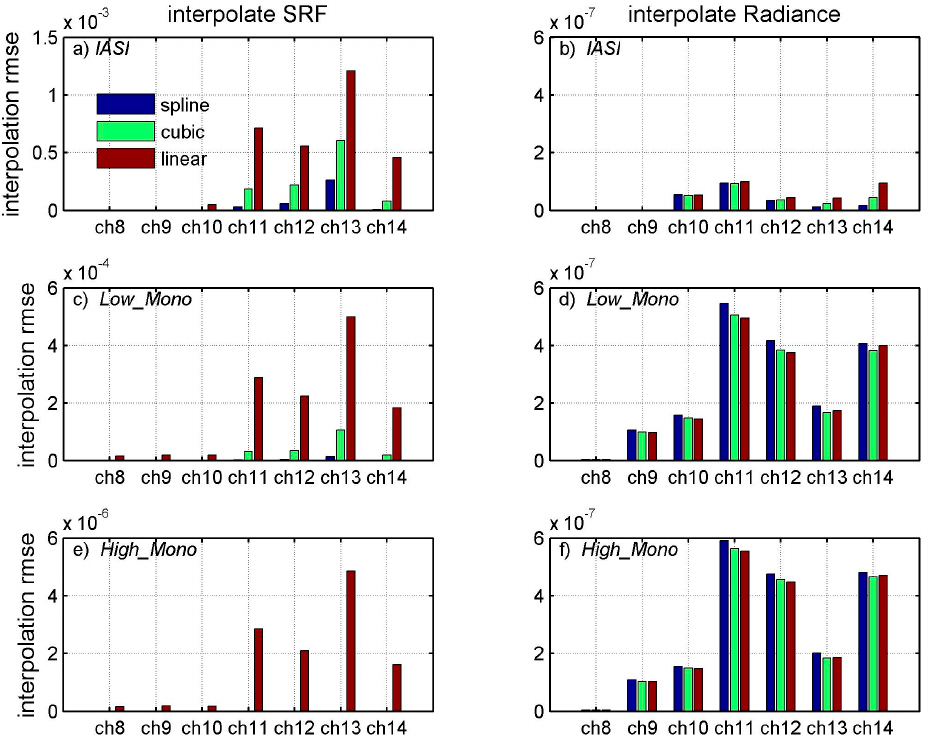
Figure 3. Mean root mean square di ff erences from di ff erent interpolation methods for 7 AGRI IR bands, hyperspectral sounder radiances with 0.25 (Infrared Atmospheric Sounder Interferometer (IASI), apodized, upper), 0.1 (unapodized, middle) and 0.001 (unapodized, lower) cm − 1 resolutions, respectively, are used. Six typical atmospheric profiles are used in radiance calculations.